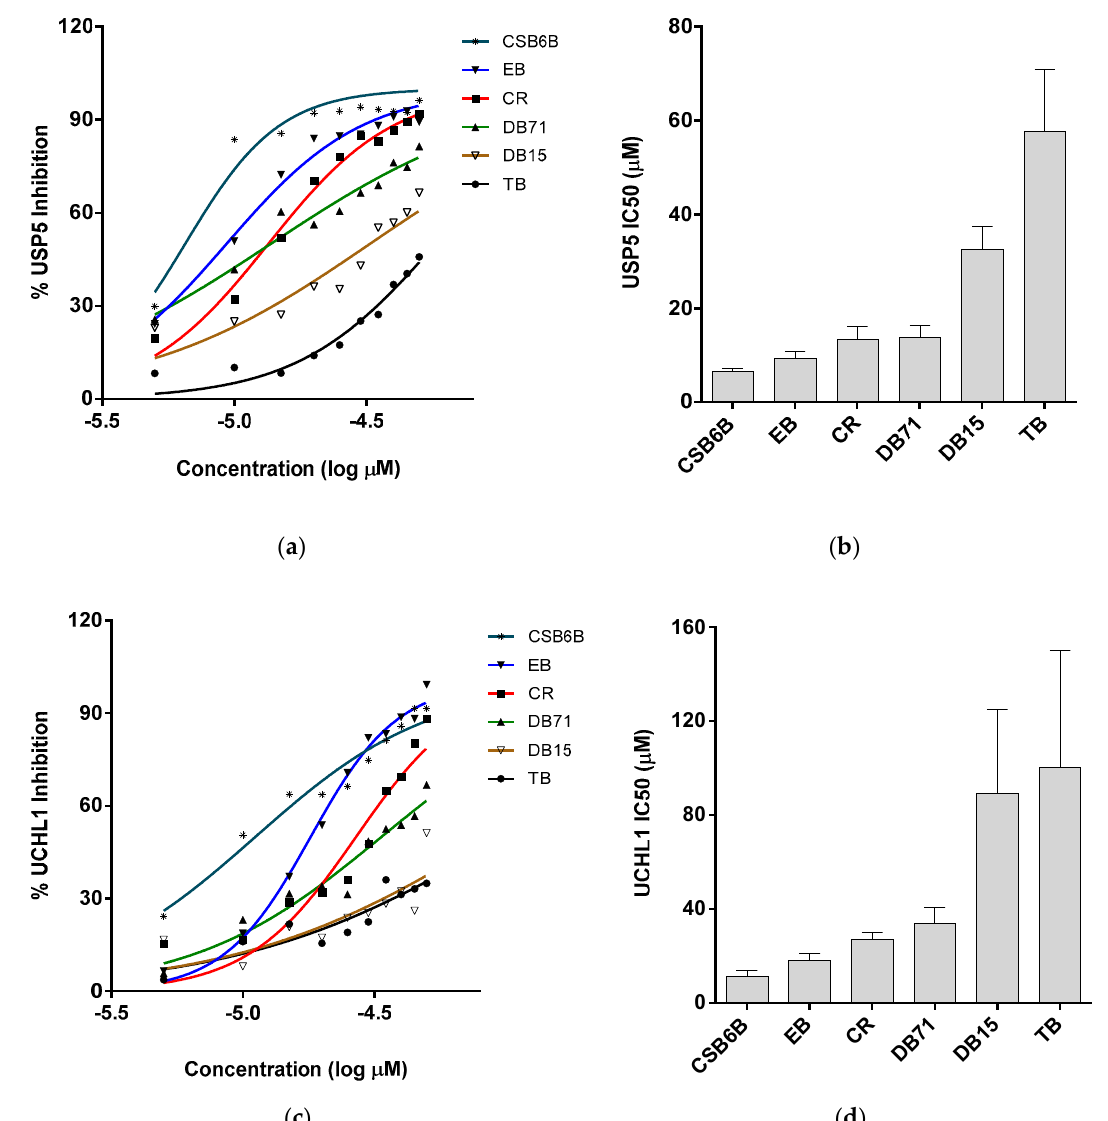
Figure 3. Inhibitory activities of ubiquitin-binding compounds on deubiquitinases’ (DUBs) activities. Activities of USP5 ( a , b ) and UCHL1 ( c , d ) upon treatment with different compounds. ( a , c ) Inhibitory activity of ubiquitin-binding compounds at different concentration are plotted as percent inhibition using the quantified band intensities. ( b , d ) IC 50 values of different compounds against USP5 and UCHL1 analyzed from Figure 3a,c are plotted, respectively.